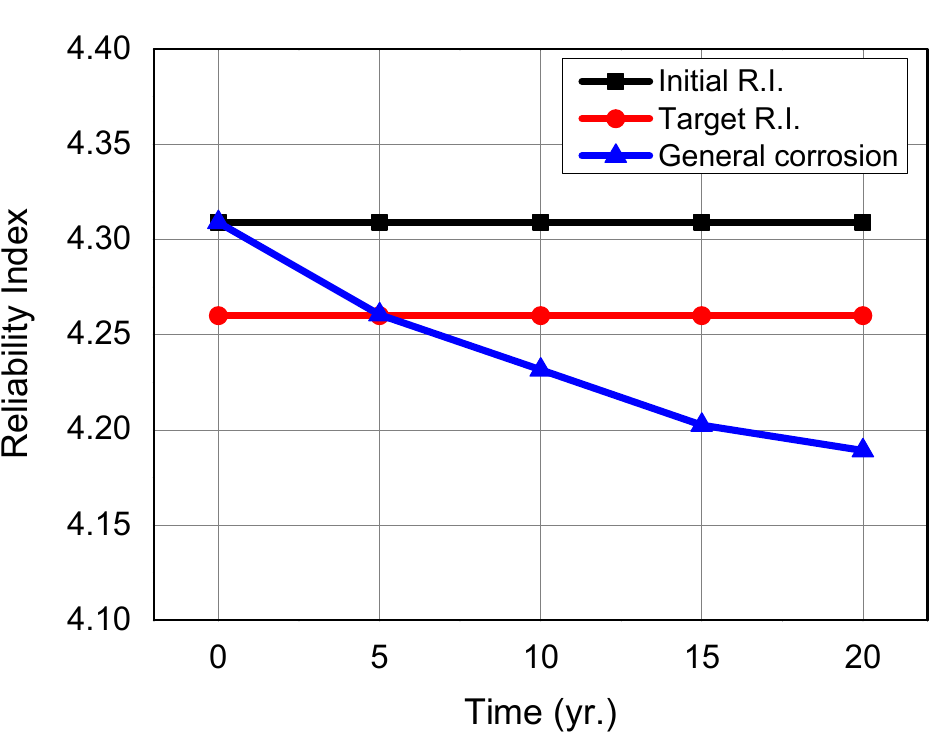
Figure 7. Results of structural reliability analysis with general corrosion.